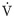
Heart rate (A) and oxygen uptake (B) intensity profiles during one set.Data from a representative subject expressed as percentage of maximum (%HRmax and %V˙O2max, respectively). Three intensity zones are delimited by the first and second ventilatory thresholds, expressed as (A) heart rate (HRVT1, HRVT2), and (B) V˙O2 (VT1, VT2) are illustrated (light to dark grey background). The dashed vertical lines represent the 6 rest periods corresponding to game end changes.